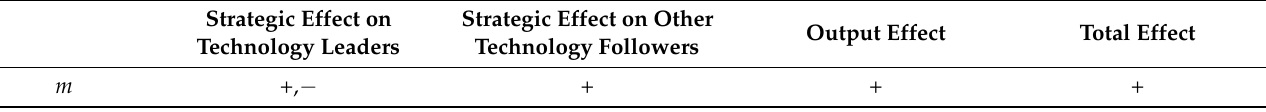
Table 2. The impact of the number of firms on individual R&D investment when K is constant. Strategic Effect on Strategic Effect